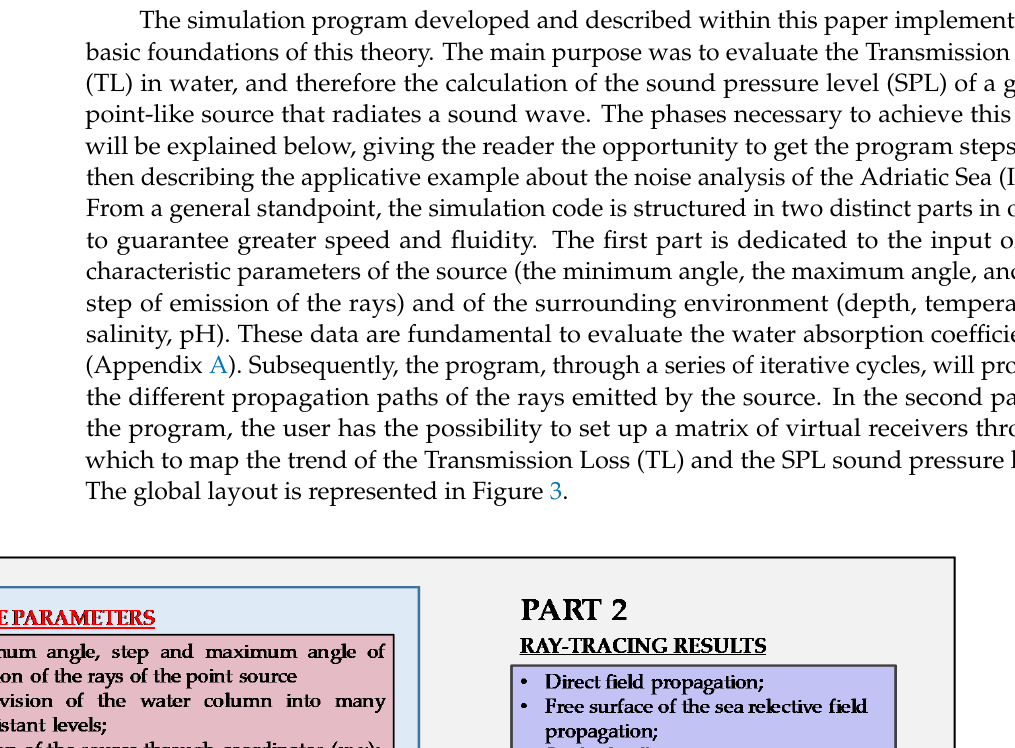
Figure 3. Logical schematic of the numerical code.